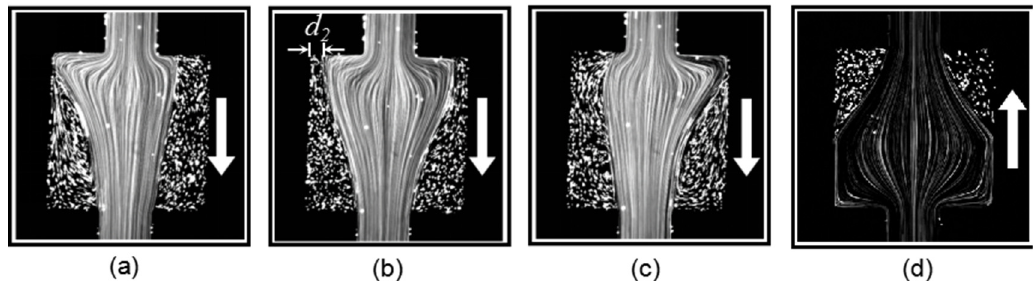
Figure 6. Viscoelastic flow pattern in the square chamber for flows along the forward direction at ( a – c ) three different instants, and ( d ) backward direction at Wi = 55.56.